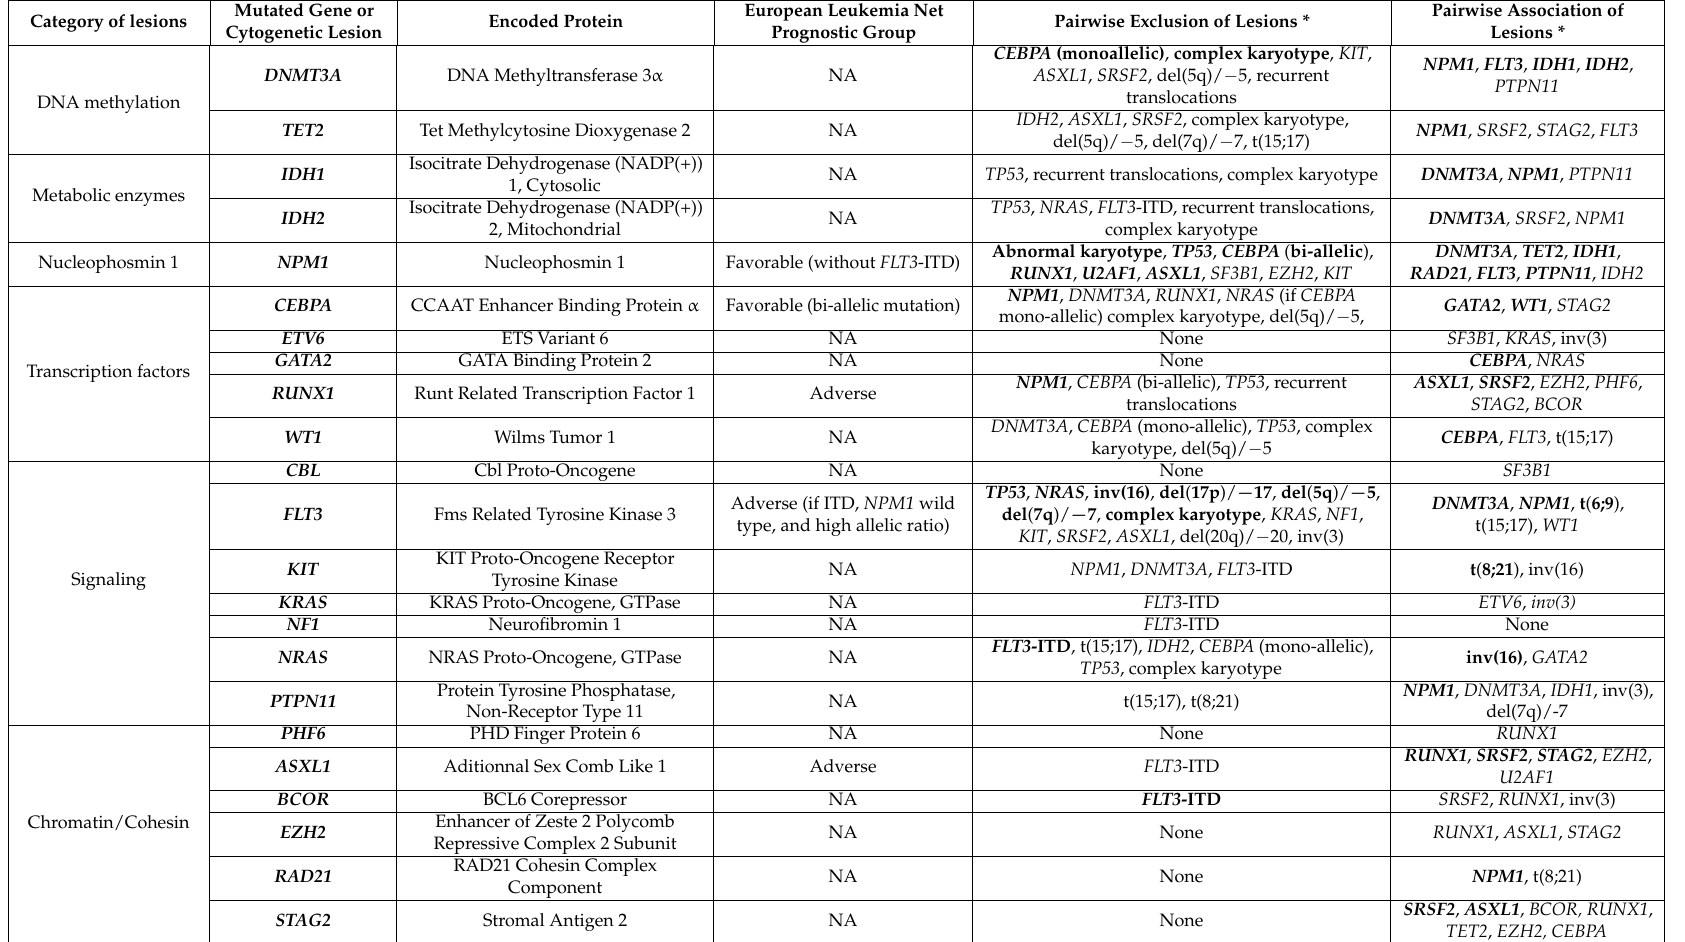
Table 1. Most frequent cytogenetic lesions and gene mutations in acute myeloid leukemia (AML). The prognostic value of each lesion is indicated, according to the European Leukemia Net groups, when available. Exclusion and associations of lesions were adapted from Papaemmanuil et al. [2]. Category of lesions